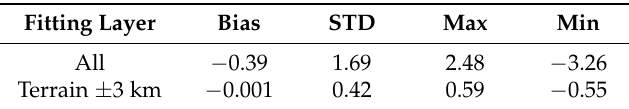
Table 4. Statistics of ZTD fitting residuals on 1 January 2014 (unit: